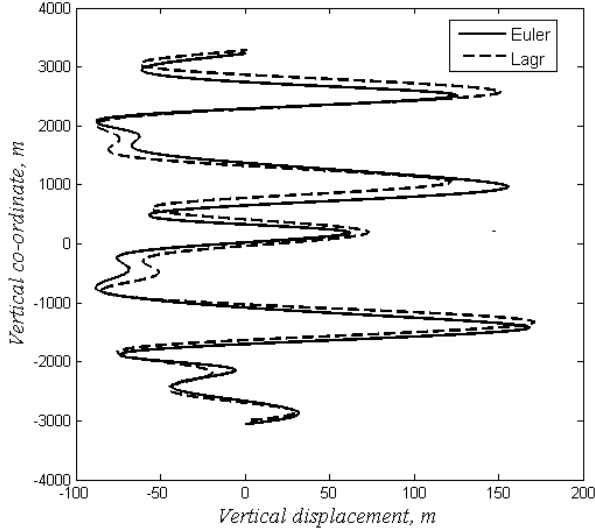
Fig. 1. One of the vertical profiles E(z) (continuous line) of the Eulerian vertical displacement field of the resonant wave triad cal- culated for M 0 =0.33, x 0 = 3770m and t 0 =2318.4s. Also shown are vertical displacements S c (a = x 0 ,c,t 0 ) = L(c) of the parcels with the same Lagrangian horizontal co-ordinate a = x 0 and different vertical co-ordinates c − c r (dashed line), c r is some reference co-ordinate c taken inside a given atmospheric